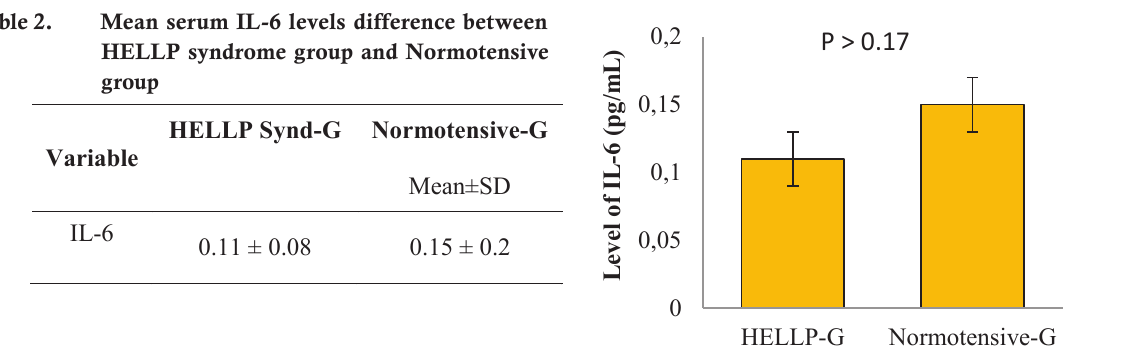
Figure 1. Independent T test on IL-6 Concentration